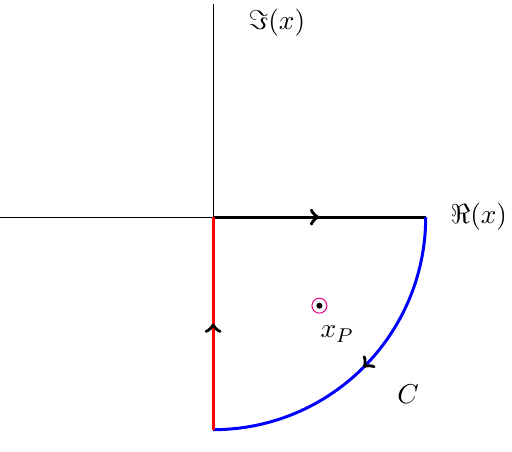
Figure 3. Contour prescription for